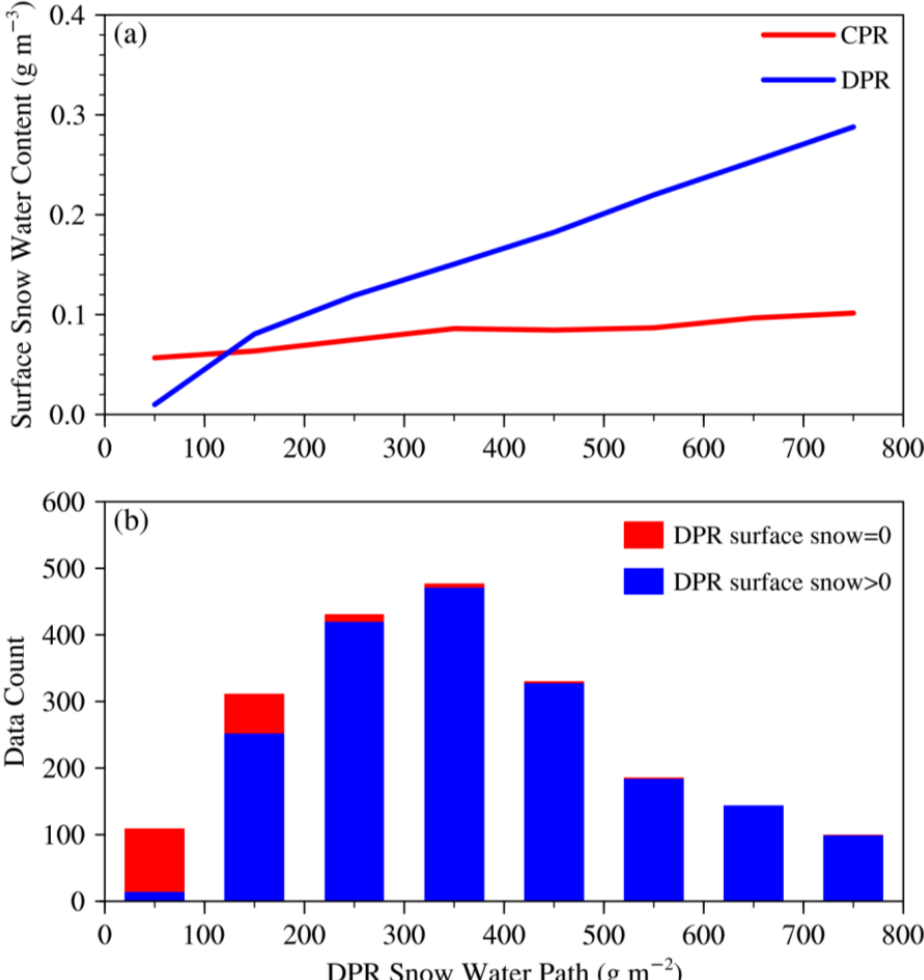
Figure 8. ( a ) Mean surface snow water content and ( b ) data count of CPR and DPR snow water content profiles grouped by DPR snow water paths under the condition that both CPR and DPR detect the falling snow.